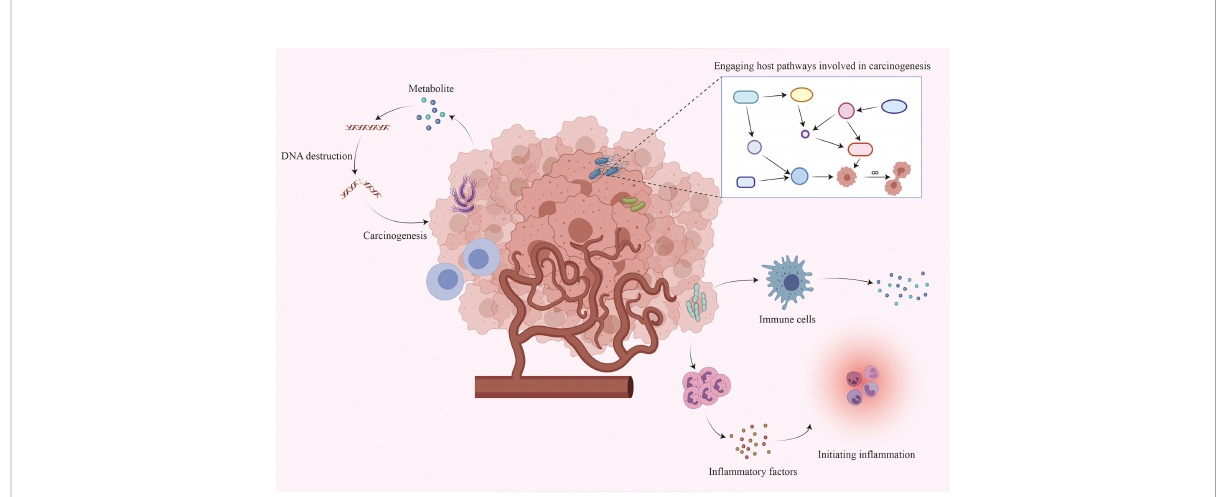
FIGURE 1 Interaction between the intratumoral microbiome and tumor cells. Although the mechanism by which the intratumoral microbiome promotes tumorigenesis remains unclear, three major mechanisms may contribute to tumorigenesis: increasing the mutation rate by directly destroying DNA, regulating oncogenic signaling pathways, and initiating in fl ammation and interacting with the host immune